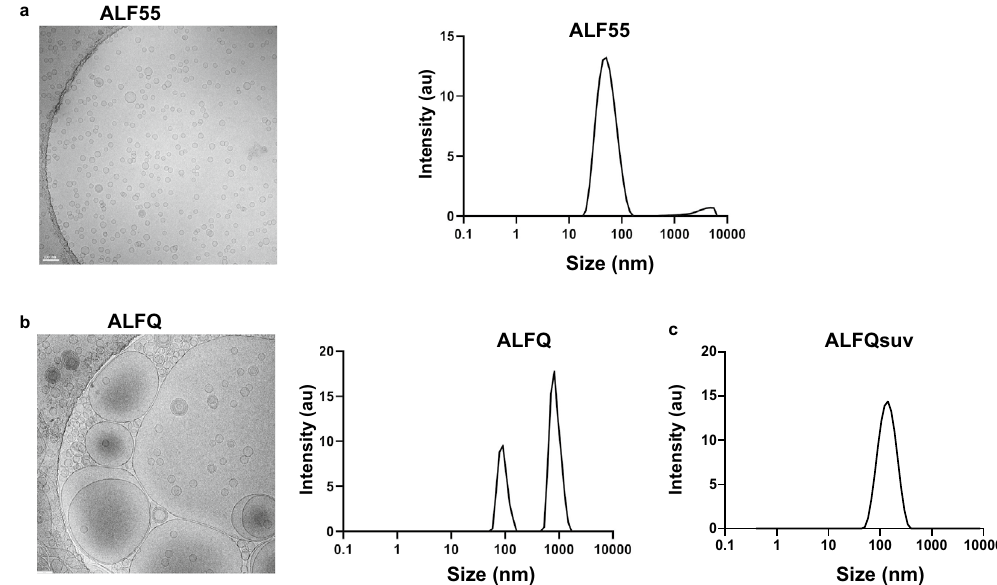
Figure 1. Visualization and sizing of ALF55 and ALFQ. ALF55, ALFQ, and ALFQsuv samples were visualized by cryo-electron microscopy (cryo-EM) and size distributions were measured by dynamic light scattering analysis (DLS). ( a ) Shows EM of small unilamellar vesicles in ALF55 (left) and their narrow size distribution (right). ( b ) Shows EM of both small and large vesicles in ALFQ (left) and a wider size distribution of the small and some large vesicles (right). However, DLS is not suitable to capture the range of the large size particles in ALFQ. (c ) Shows the narrow size distribution of the vesicles in